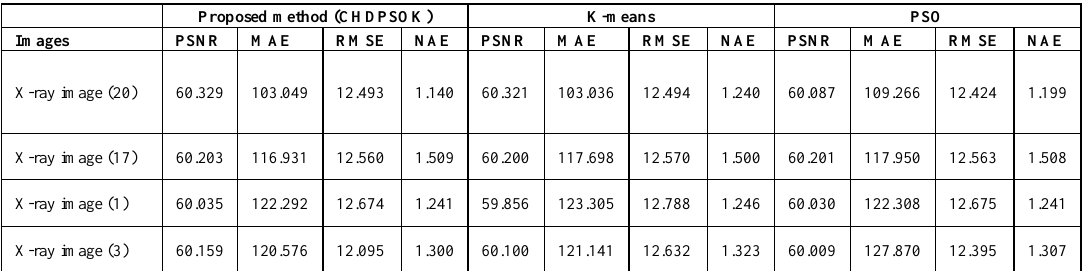
Table 2. Comparison of the proposed approach with standard K-means algorithm on segmented images with white patches. Proposed method (CHDPSOK) K-means PSO Images